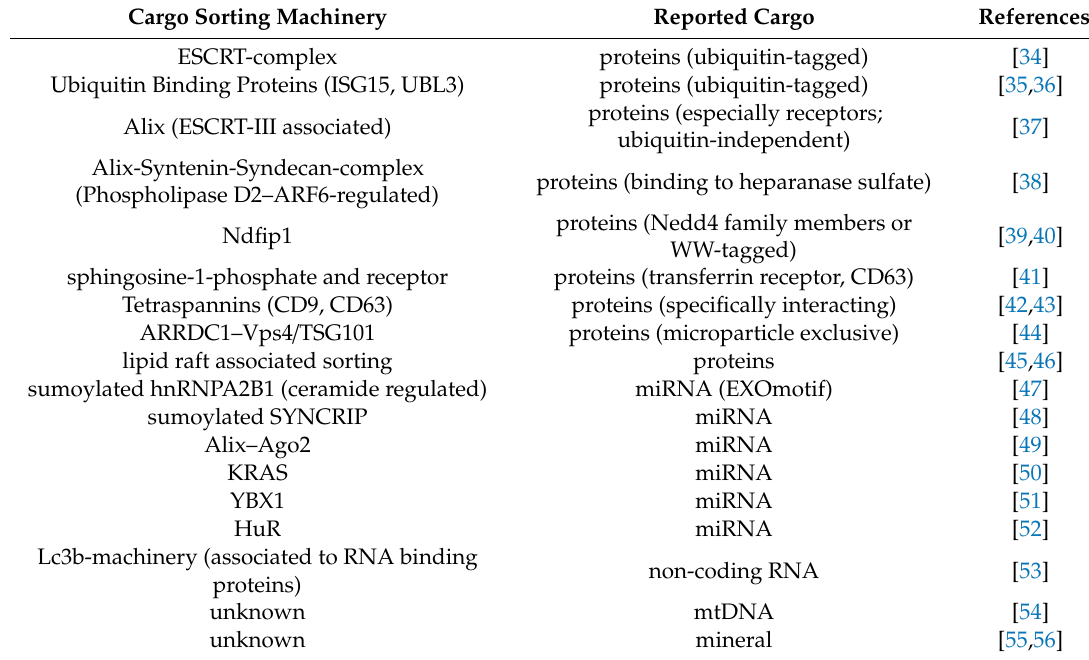
Table 1. Extracellular vesicle (EV) cargo loading machineries and their reported